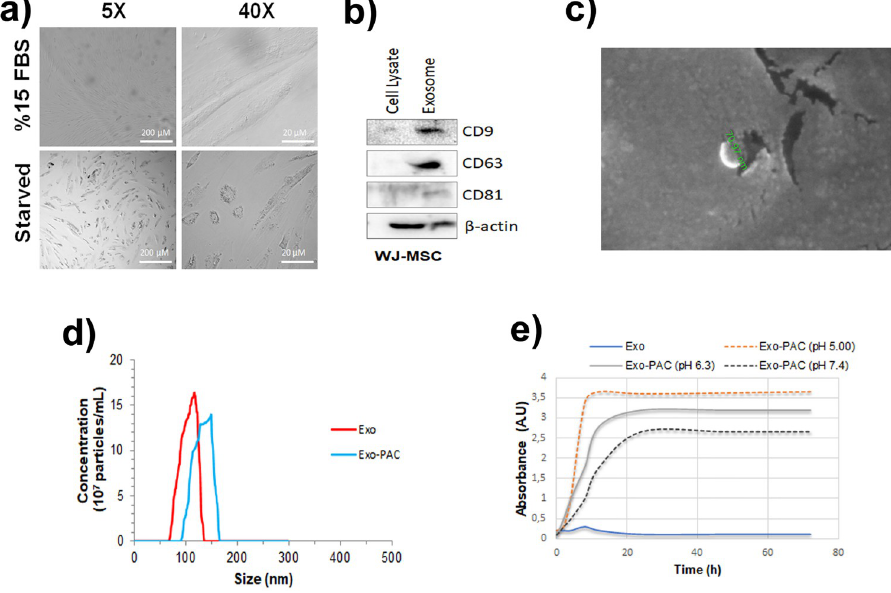
Fig 2. WJ-MSC exosomes characterization a) Morphologies of WJ-MSC cells grown in serum and serum-free medium b) CD9, CD63, and CD81 western blot bands of exosomes isolated from WJ-MSC c) Exo and Exo-PAC SEM analysis images d) Exo and Exo-PAC size analysis e) Exo and Exo-PAC time-dependent PAC release